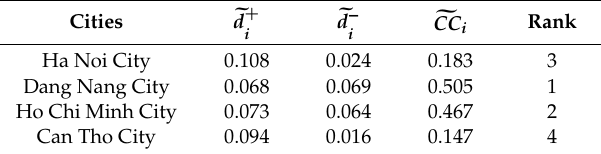
Table 16. Closeness coe ffi cients and rank of alternatives for social sustainability.